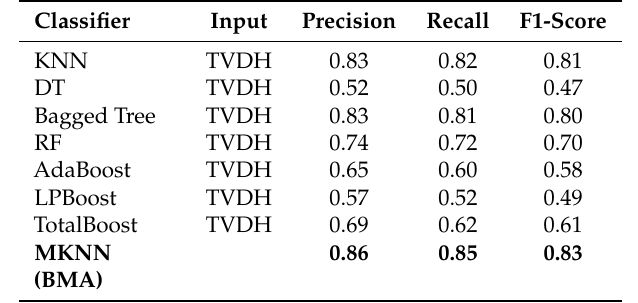
Table 2. Comparison of MKNN with respect to the standard supervised learning approach. LPBoost, linear programming